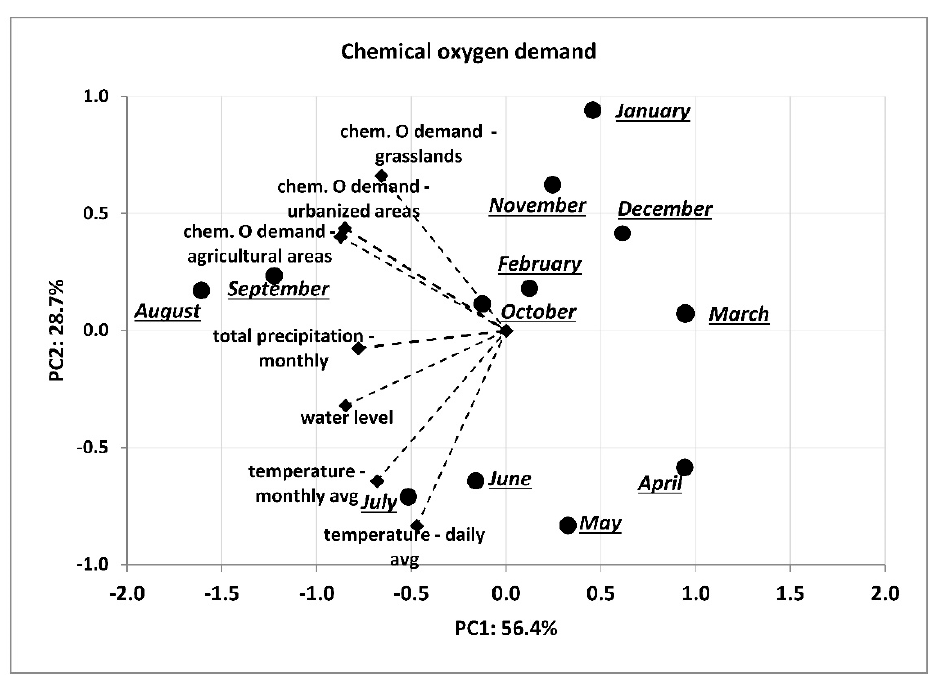
Figure 12. PCA analysis for the relationships between: characterising the catchment area land use, weather conditions and the chemical oxygen concentration in the Utrata River.